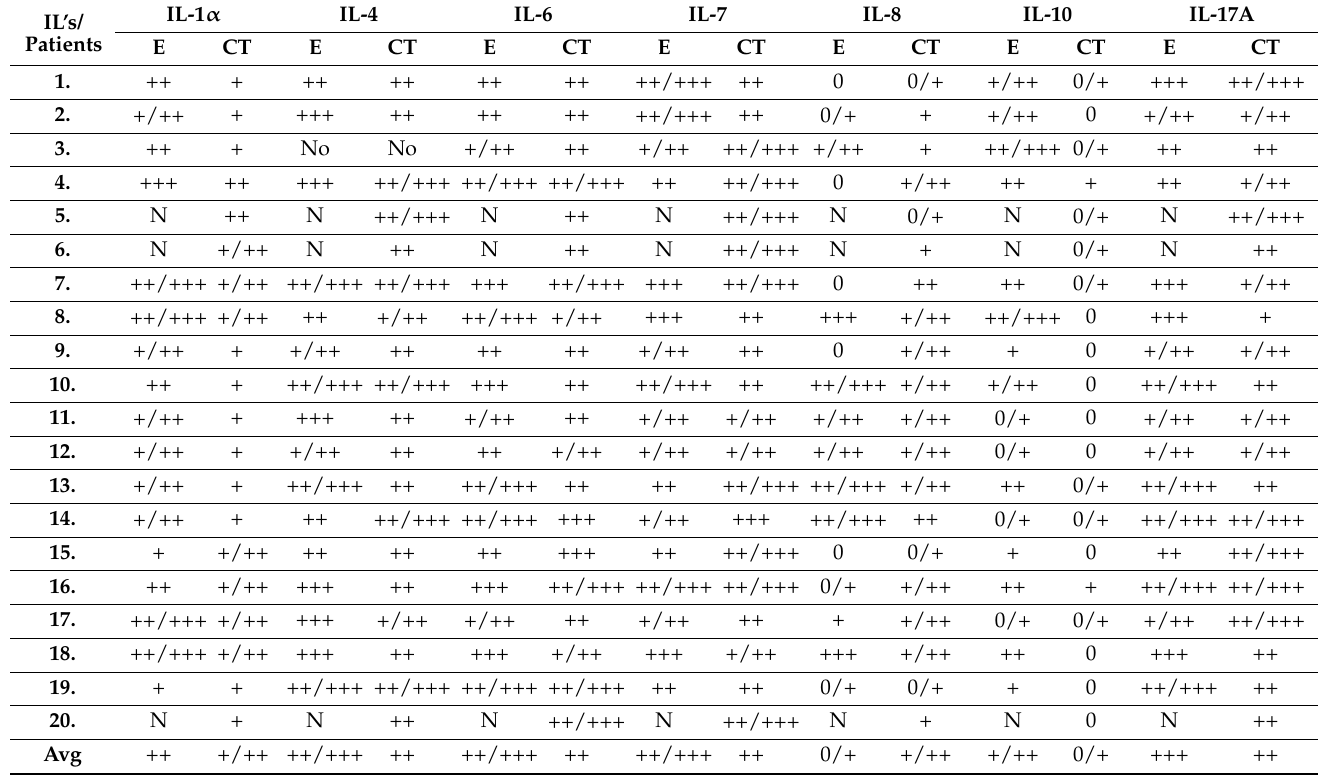
Table 2. Number of interleukin positive cells in the gallbladder epithelium and connective tissue of control samples.